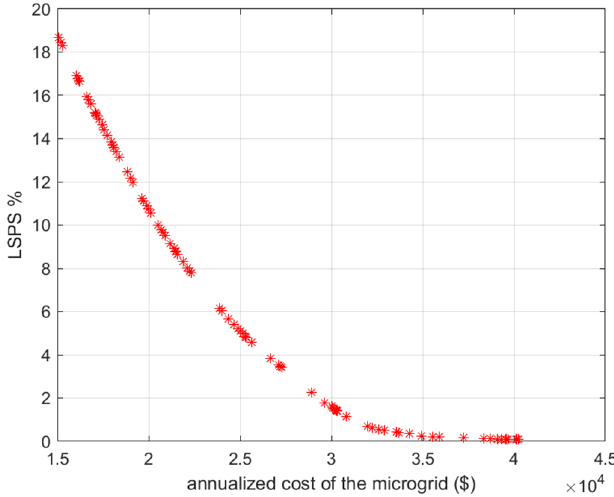
Figure 6. Relationship between power supply reliability and annualized cost.